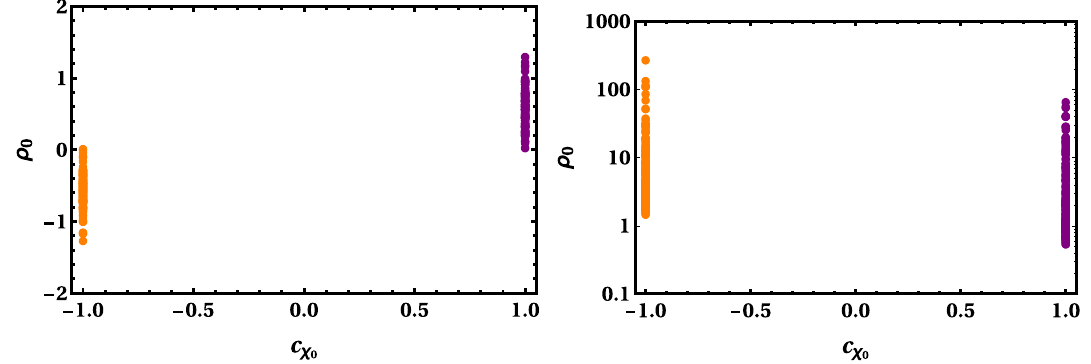
Fig. 2 The corresponding values of the minima of the scanned points in Fig. 1 in ρ 0 vs c χ (right panel)